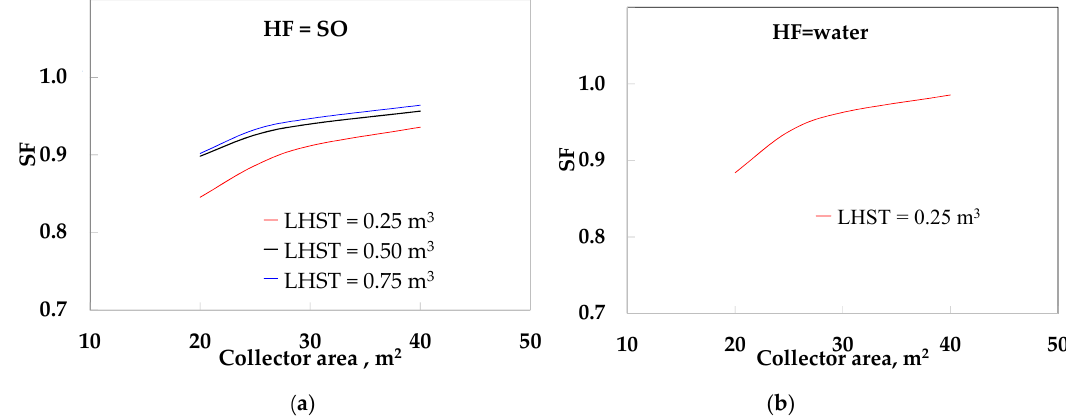
Figure 15. Solar fraction against PTC collector area for LHST with a tempering valve (configuration 3) using ( a ) SO and ( b ) water.